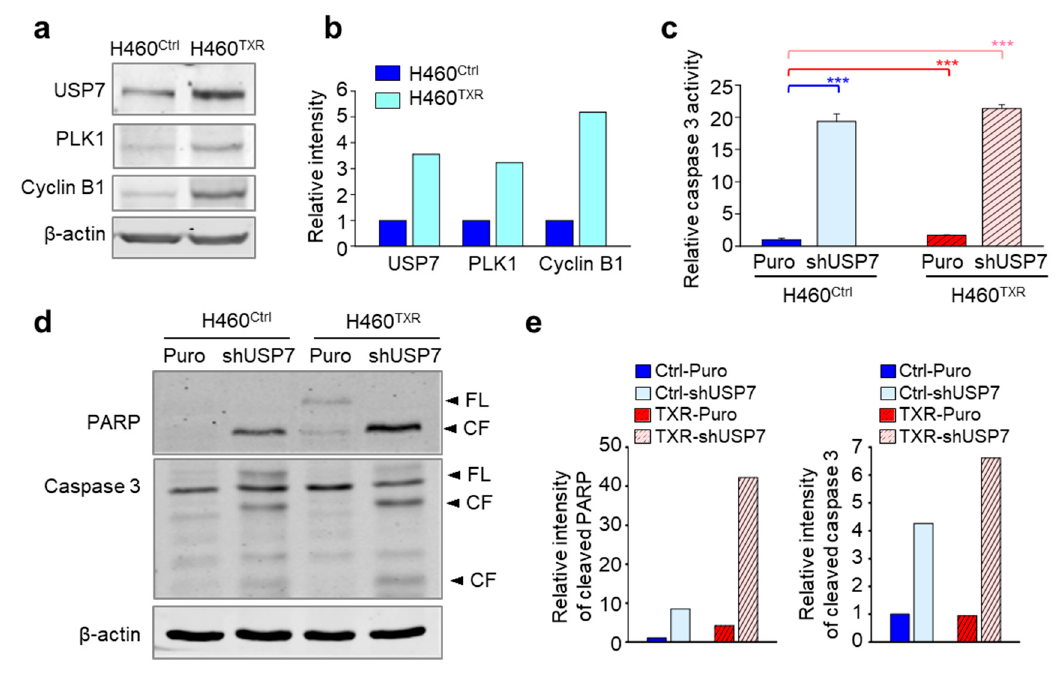
Figure 4. Targeting USP7 increases the sensitivity of paclitaxel-resistant lung cancer. ( a ) Immunoblot analysis was performed to detect the levels of USP7, PLK1, and cyclin B1 in NCI-H460 and NCI-H460 TXR cells using specific anti-USP7, anti-PLK1, anti-cyclin B1, and anti- β -actin antibodies. ( b ) The band intensities from the immunoblots in Figure 4a were quantified USP7, PLK1, and cyclin B1 relative to the intensities of β -actin were quantified using LI-COR Odyssey software (Li-COR Biosciences), normalized, and plotted. ( c – e ) USP7 was depleted in NCI-H460 and NCI-H460 TXR cells using lentiviral USP7 shRNA. ( c ) Cell lysates from NCI-H460 and NCI-H460 TXR cells were subjected to a fluorometric caspase 3 activity assay. The means ± SDs (error bars) of data from at least three experiments are shown. (*** p ≤ 0.001) ( d ) Immunoblot analysis was done to detect the levels of cleaved PARP and cleaved caspase 3 after USP7 depletion in NCI-H460 and NCI-H460 TXR cells. ( e ) The band intensities of cleaved PARP (left) and cleaved caspase 3 (right) from the immunoblots in Figure 4d relative to the intensities of β -actin were quantified using LI-COR Odyssey software (Li-COR Biosciences), normalized, and plotted.